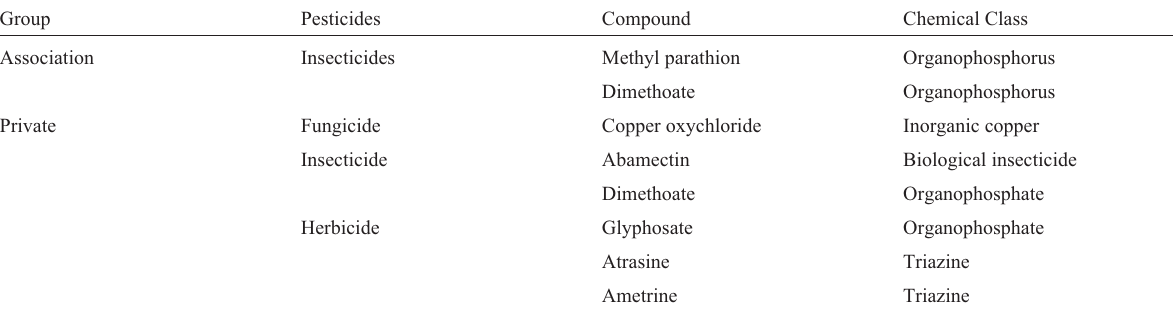
Table 2 - List of pesticides used by the employees of the association (Group1) and of the private company (Group 2). Group